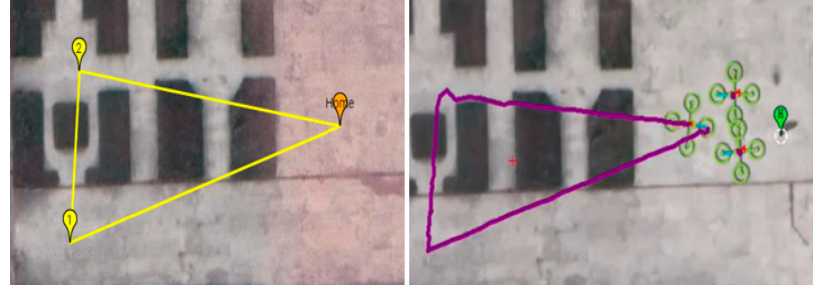
Figure 21. Planned path and UAV mission execution trajectory.